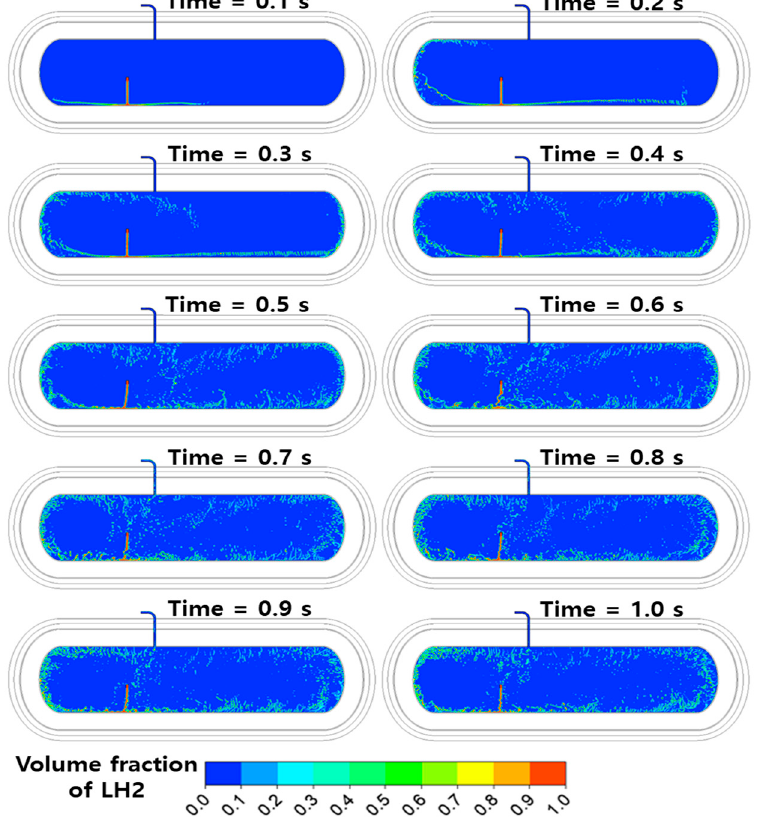
Figure 5. Distributions of volume fraction of liquid hydrogen according to charging process.